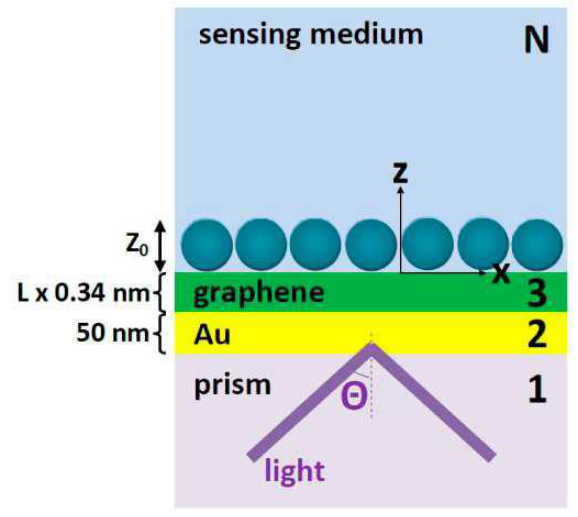
Figure 6. N-layer model for surface plasmon resonance (SPR) biosensor: prism | Au (50 nm) | graphene (L×0.34 nm) | sensing medium, where L is the number of graphene layers, and z0 = 100 nm is the biomolecule layer thickness [61].